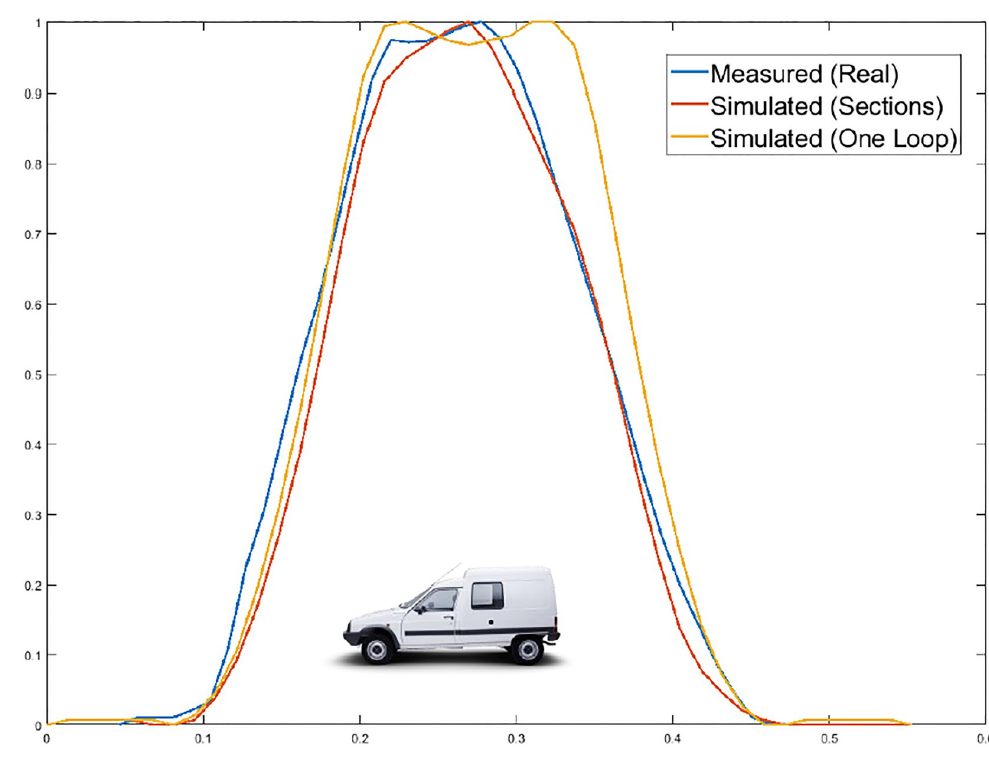
Fig 17. Citroe¨n C-15 simulation.